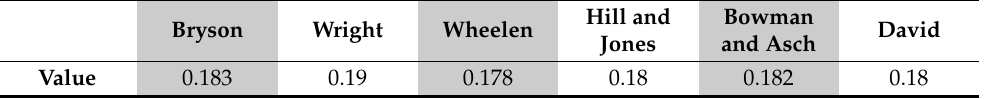
Table 11. Final values of alternatives.